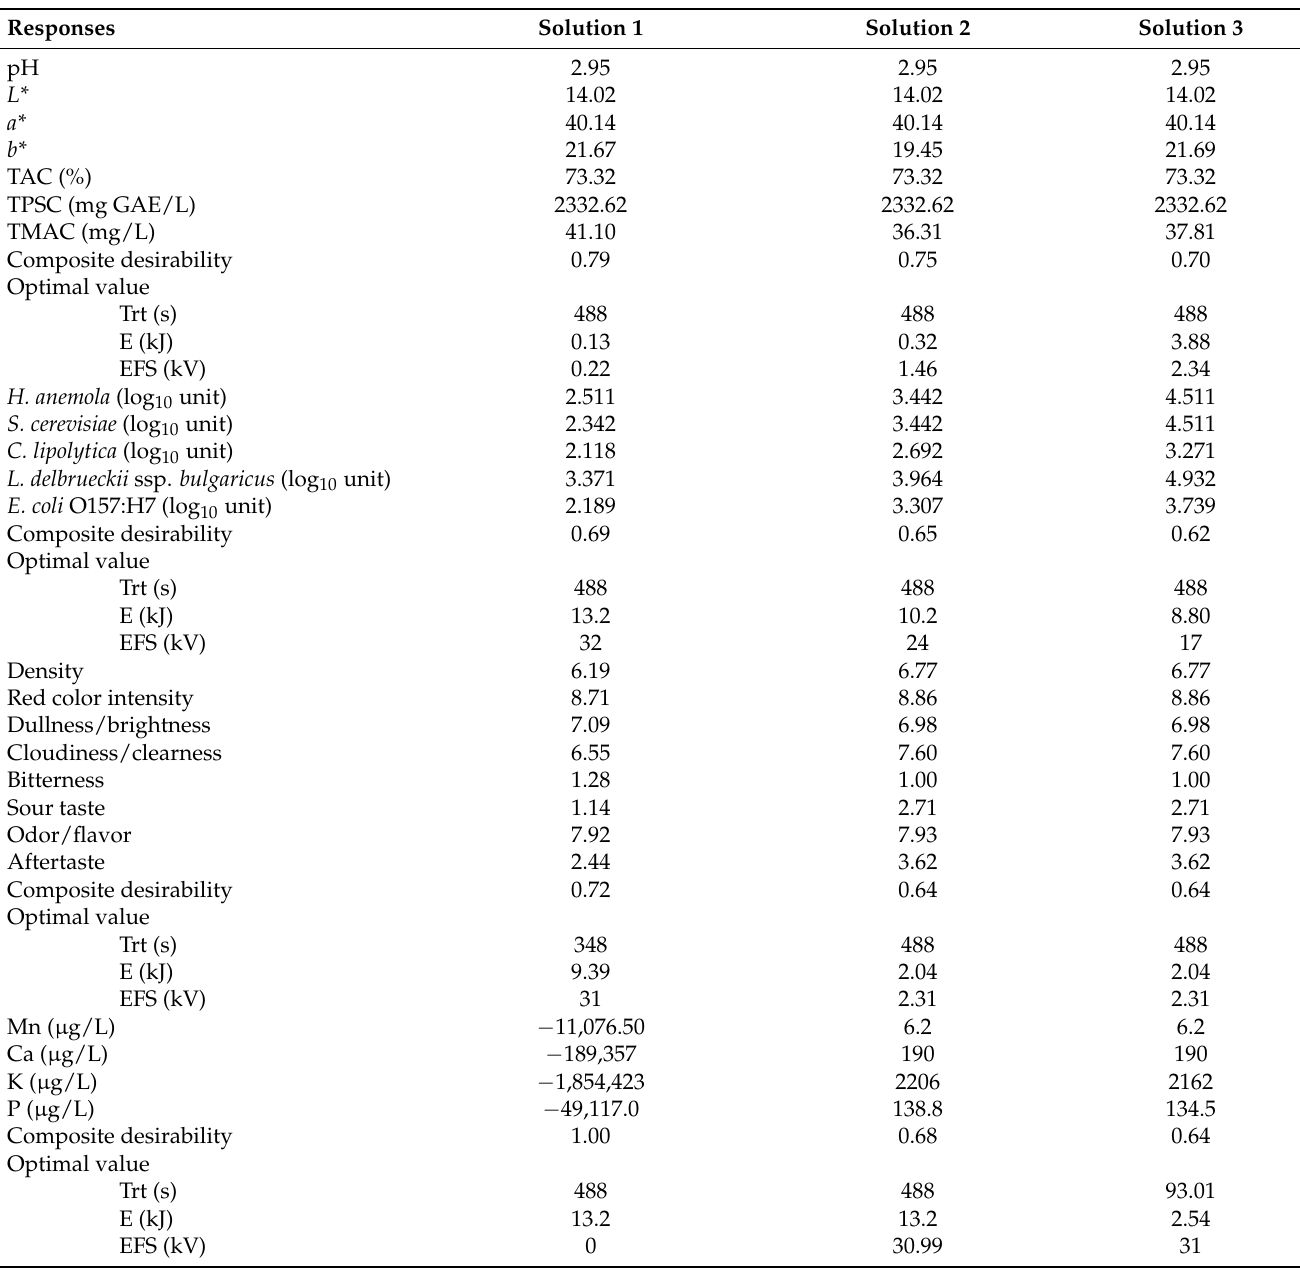
Table 6. Three joint optimizations of the responses variables (R) as a function of the applied energies in the range of 2.4 and 13.2 kJ for red wine